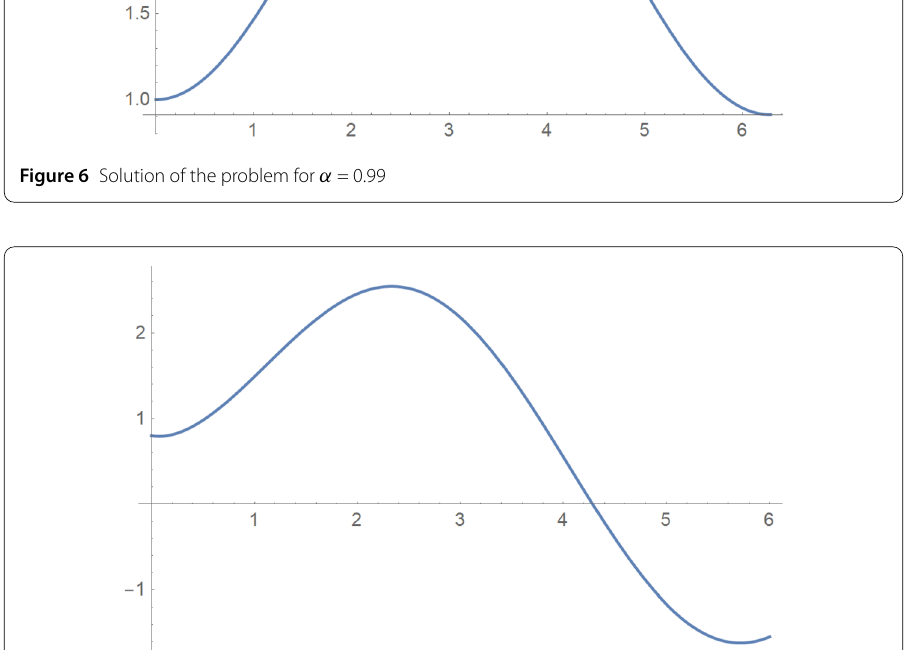
Figure 7 Solution of the problem for α = w = c =